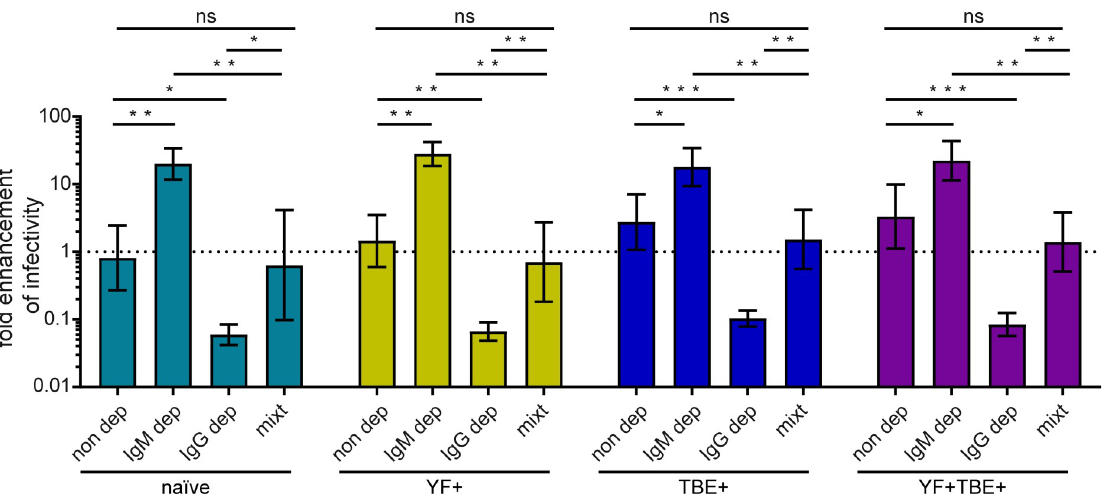
Fig 5. Effect of IgM and IgG depletion on ADE of Zika virus infection. The four serum pools were depleted from IgM or IgG as described in Methods. Fc γ receptor-positive K562 cells were infected with Zika virus in the presence of a 1:1000 dilution of each pool, either non-depleted (non dep), IgM depleted (IgM dep), IgG depleted (IgG dep) or a reconstituted sample, i.e. a mixture of the IgM and IgG- depleted pools (mixt). Data are shown as mean values +/- SEM from three independent experiments. Dotted line indicates no enhancement of infection. Statistical comparisons (with the original and reconstituted samples) were performed by applying a GLM with linear contrasts and a Bonferroni-Holm adjustment and are indicated at the top of the figure. ns, not significant; � , p < 0.05; �� , p < 0.01; ��� , p < 0.001. Na ï ve, flavivirus na ï ve serum pool; YF+, yellow fever pre-vaccinated serum pool; TBE+, tick-borne encephalitis pre-vaccinated serum pool; YF+TBE+: yellow fever and tick-borne encephalitis pre-vaccinated serum pool.